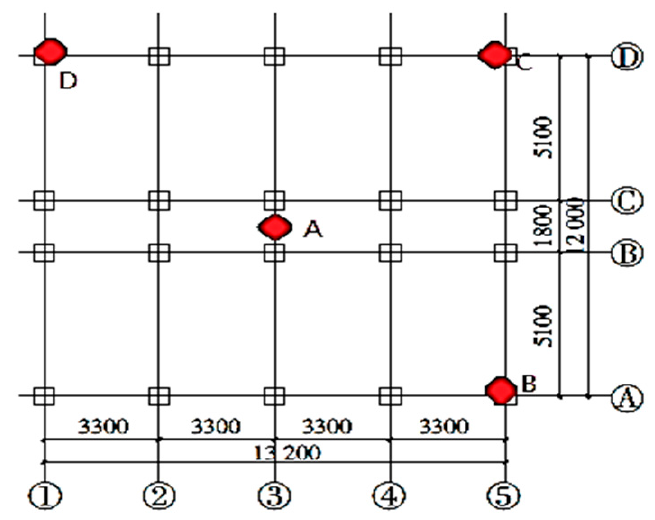
Figure 3. The layout of accelerators and displacement meters.